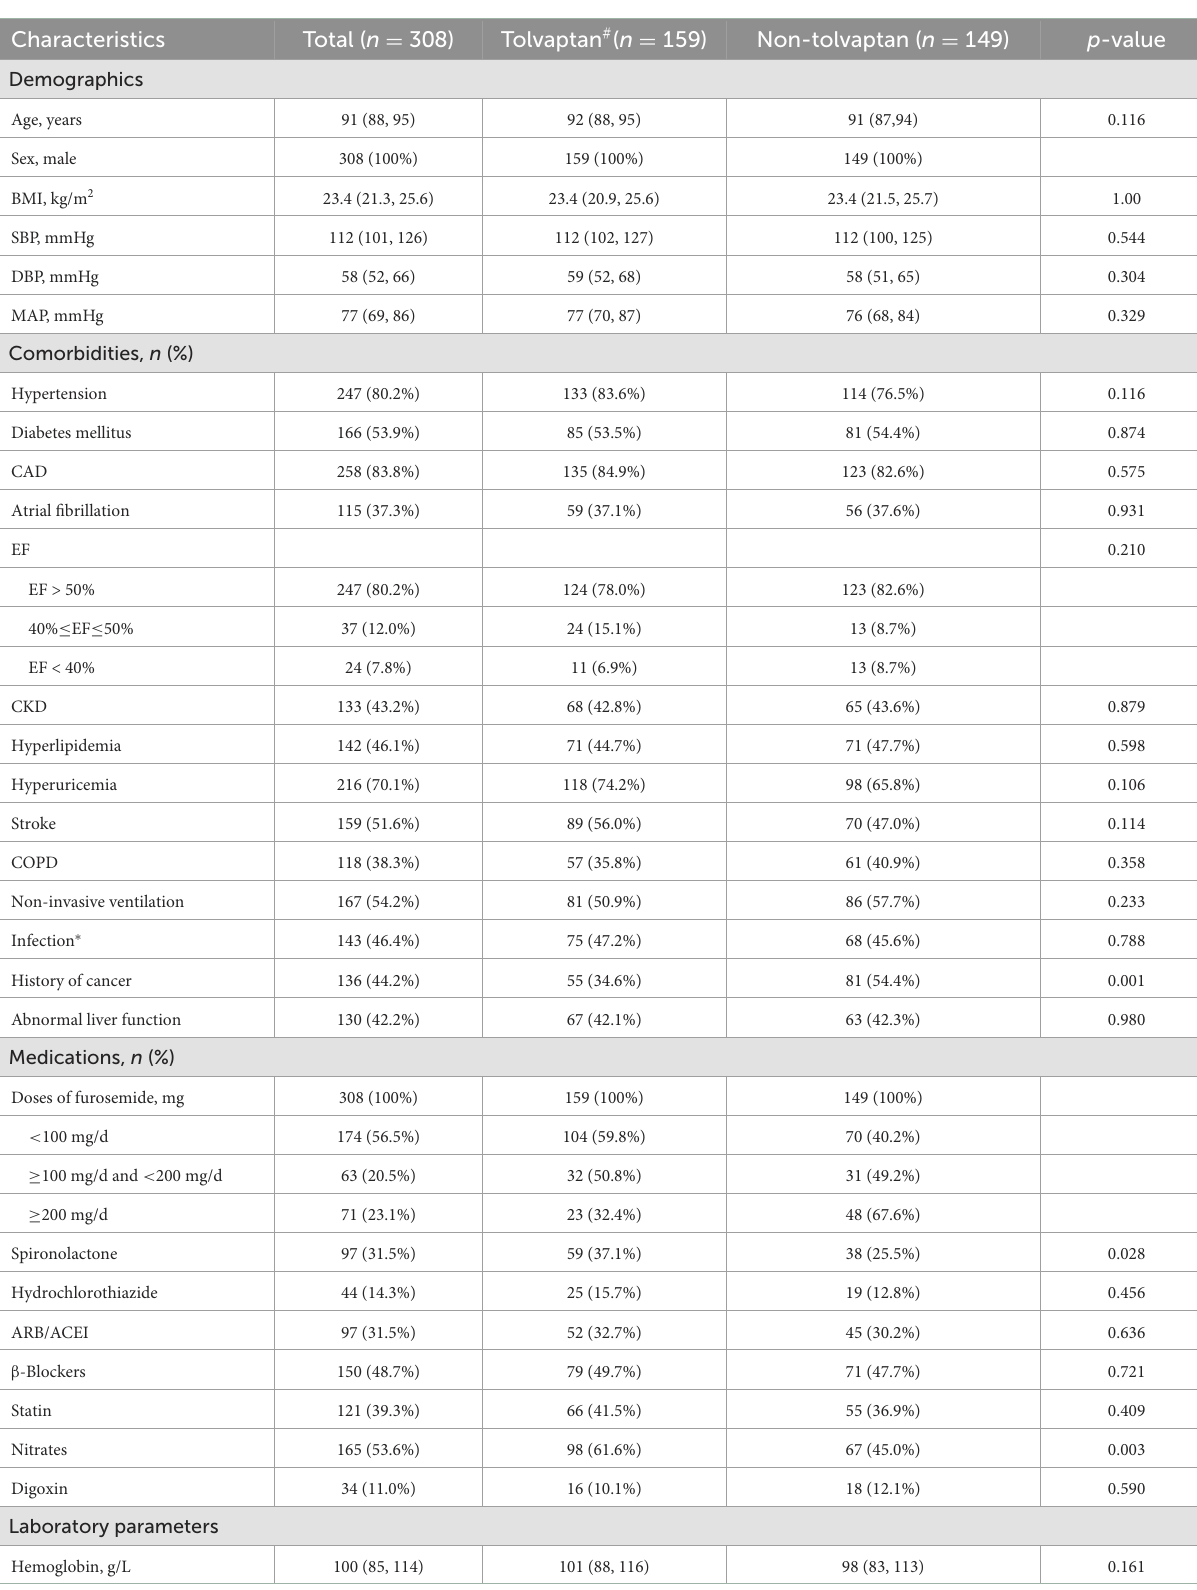
TABLE 1 Baseline characteristics of the study